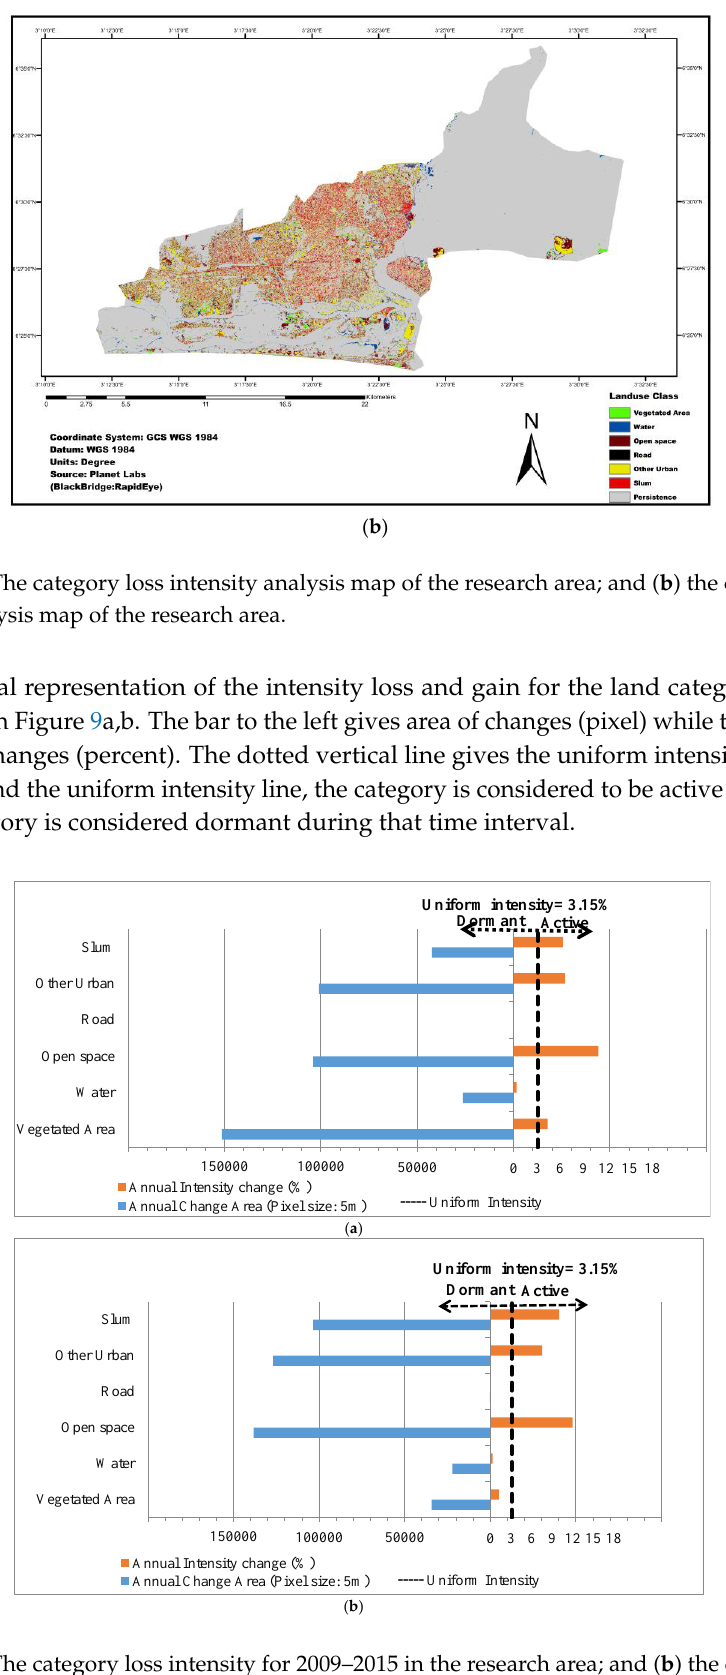
Figure 9. ( a ) The category loss intensity for 2009–2015 in the research area; and ( b ) the category gain intensity for 2009–2015 in research